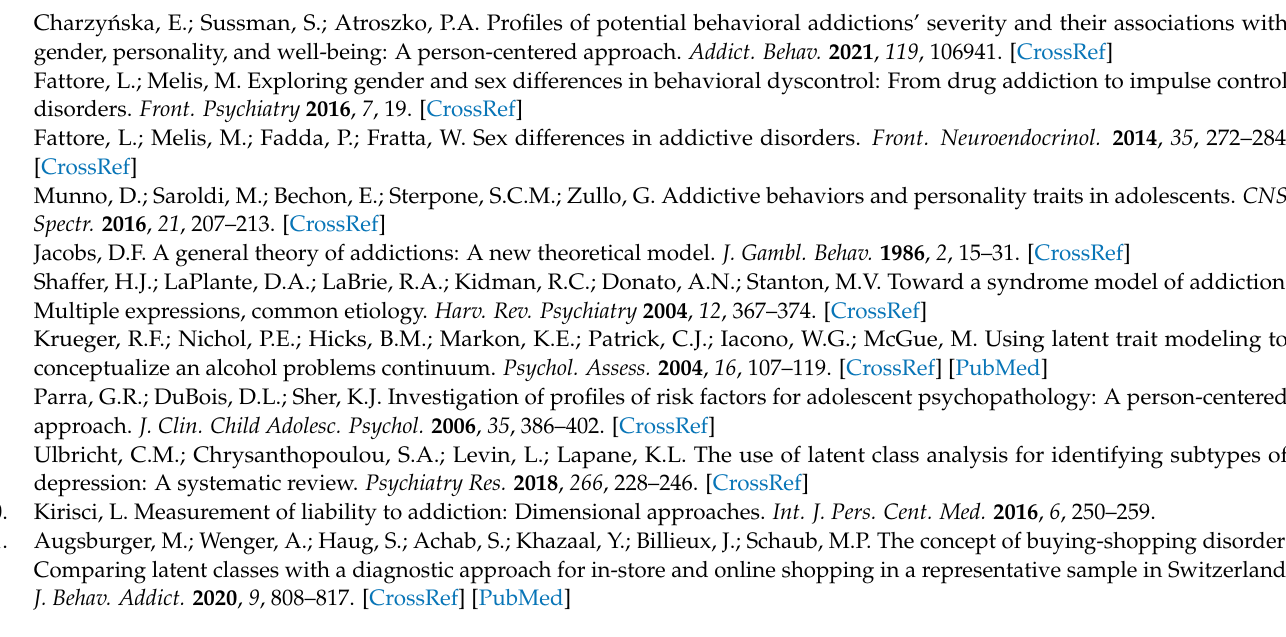
Table S4: Prevalence and Co-Occurrence of Potential Behavioral Addictions (BAs) among Four Latent Profiles, Table S5: The Frequency of the Number of BAs among the Latent Profiles, Table S6: Summary Comparison of LCA Models for the Full Sample, Table S7: Class Comparisons for the Two-Class Solution, Table S8: Comparison of LCA Models for Persons with at Least One Behavioral Addiction, Table S9: Class Comparisons for the Three-Class Solution, Table S10: The Accuracy of Classification of Cases in General Student Sample and Subsample Positively Screened for BAs Based on LPA, Figure S1: Elbow Plot of the BIC, CAIC, and SABIC Values for the LPA Solutions, Figure S2: Elbow Plot of the BIC, CAIC, and SABIC Values for the LCA